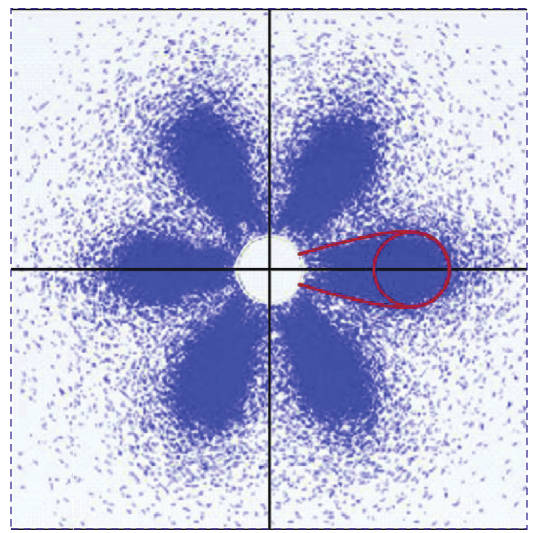
Figure 6: Soil contact bond failure range diagram at p � 0 . 4MPa.